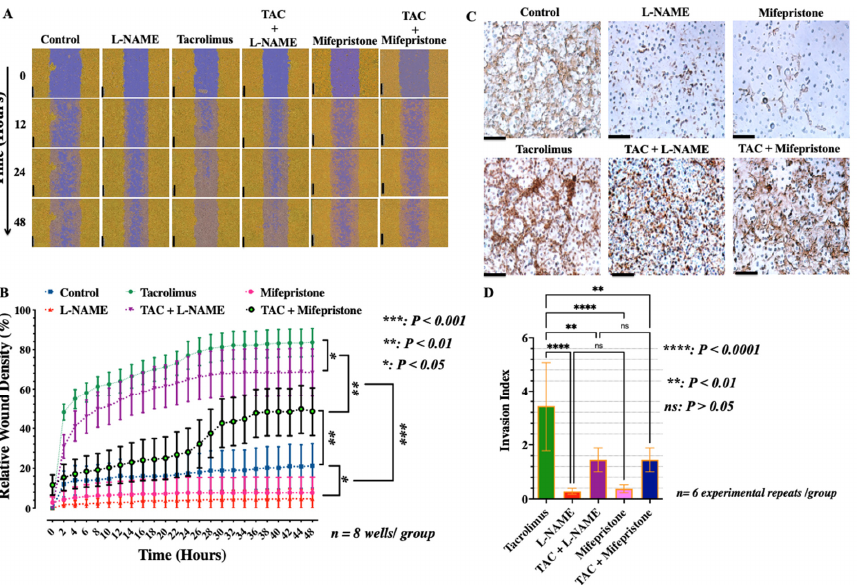
Figure 1. Tacrolimus promotes migration and invasion of the human-derived first-trimester extravillous trophoblasts in vitro. HTR-8/SVneo cells were grown to confluence in complete